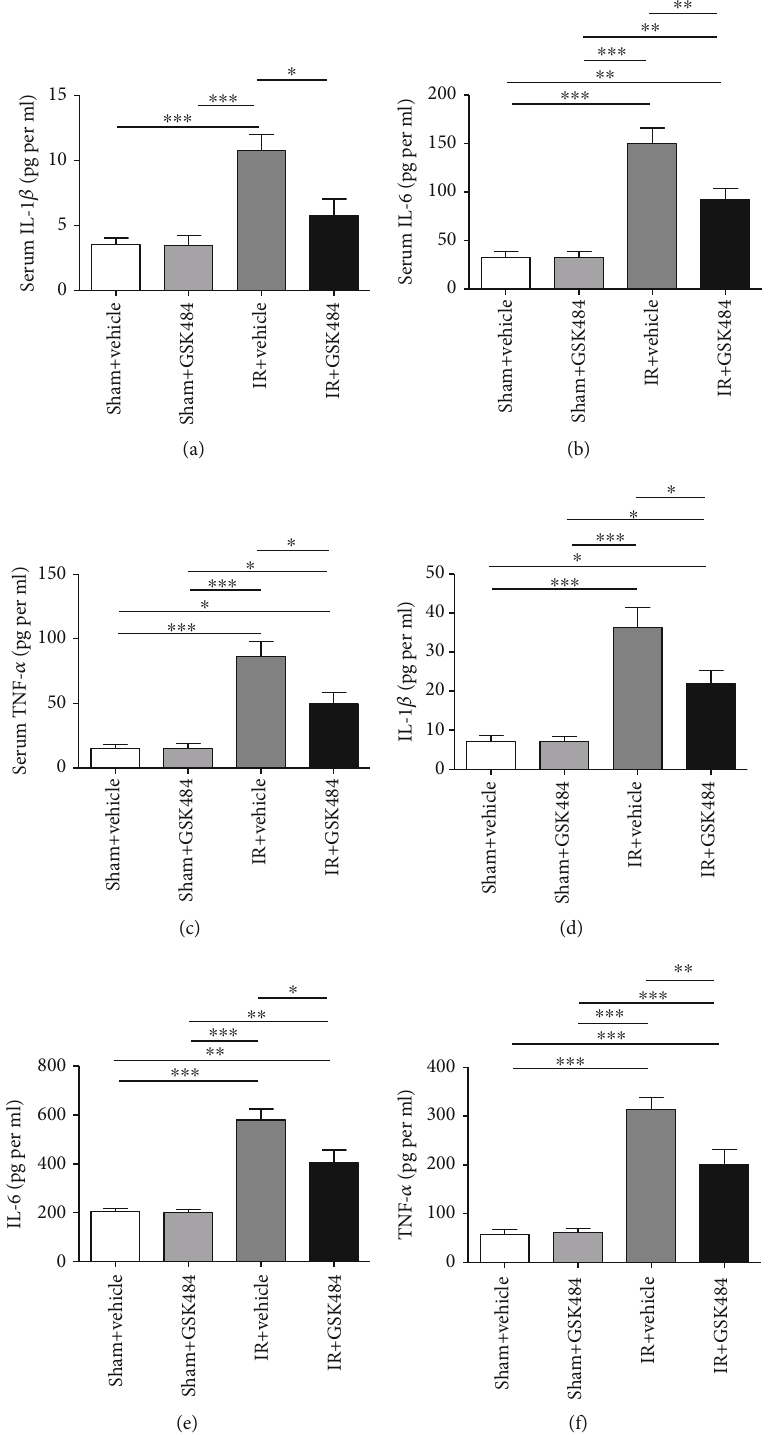
Figure 6: The in fl uence of GSK484 on in fl ammatory cytokine secretion after renal IR injury. (a) – (c) Expression levels of IL-1 β , IL-6, and TNF- α in the blood serum and (d) – (f) lung tissue homogenates. The values are presented as the means ± SEMs ; n = 6 ; ∗ p < 0 : 05 , ∗∗ p < 0 : 01 , and ∗∗∗ p < 0 : 001